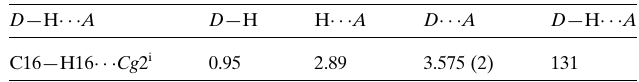
Table 1 Hydrogen-bond geometry (A˚ , (cid:4) ).